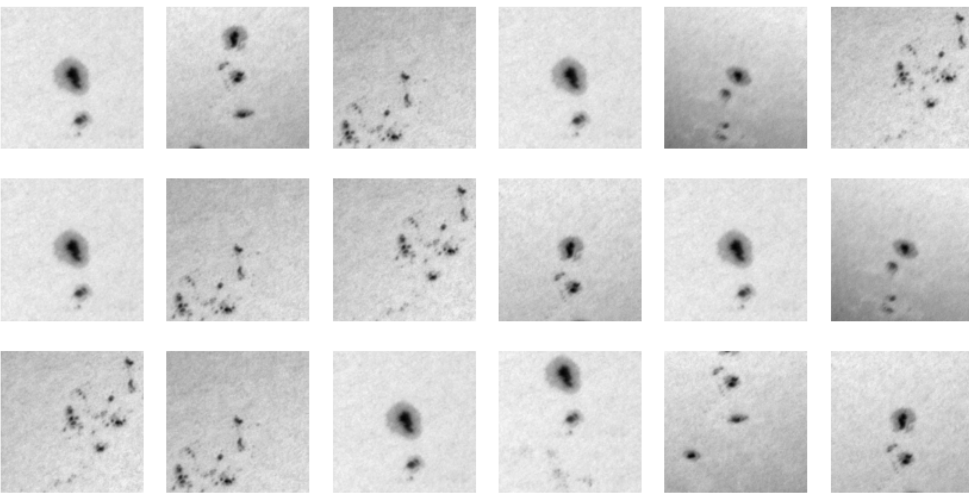
Figure 6. Patches selected in the first 15 runs of the adopted procedure performed on the continuum image presented on the right side of Figure